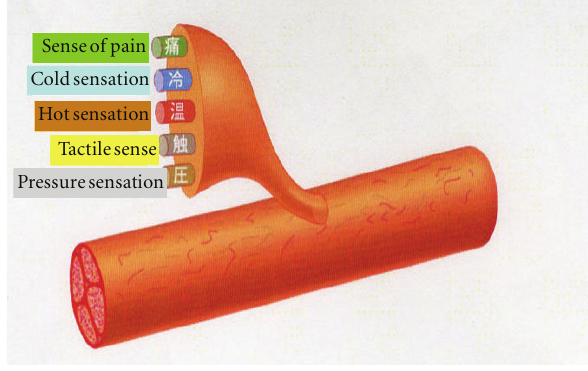
Figure 2: Various sensations in sensory nerve [18].